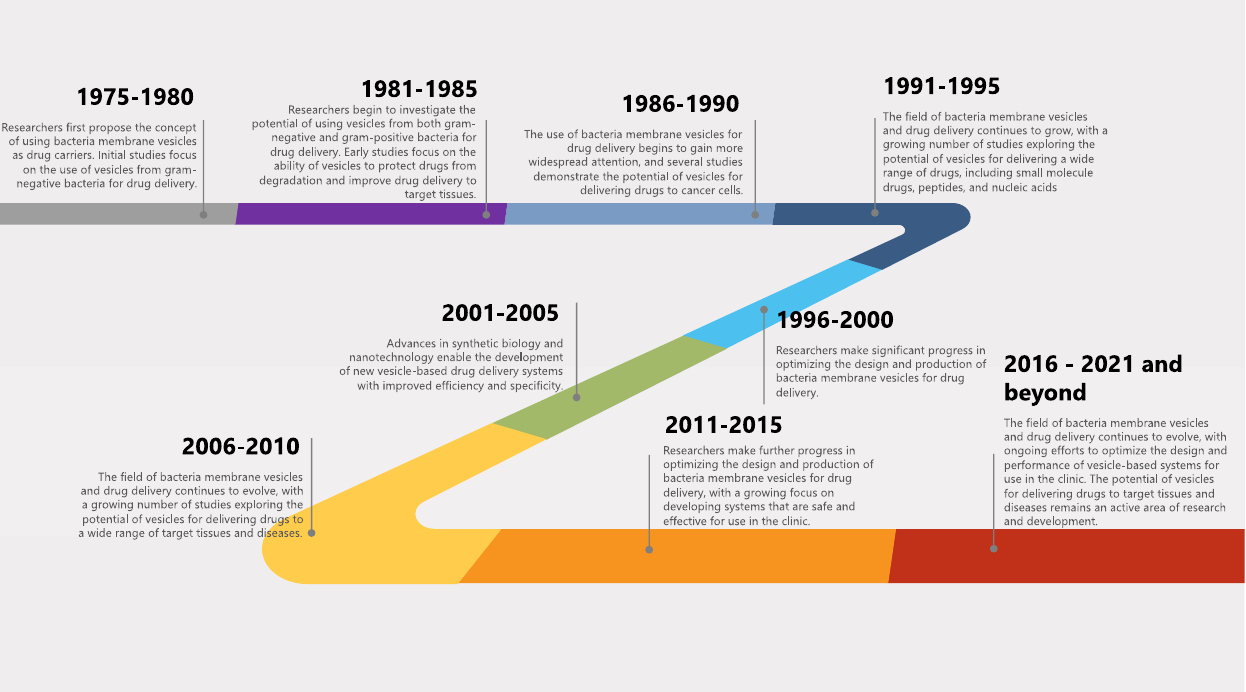
Figure 1. A general timeline of key events and milestones in the history of BMVs and their applications in drug delivery.